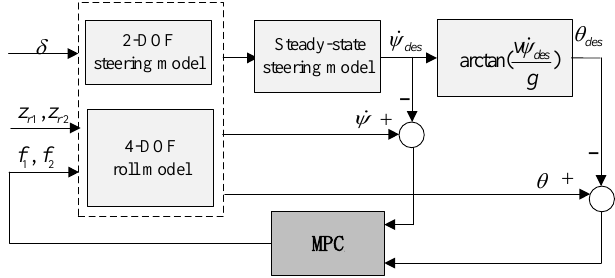
Figure 2. Block diagram of the active tilt control system.